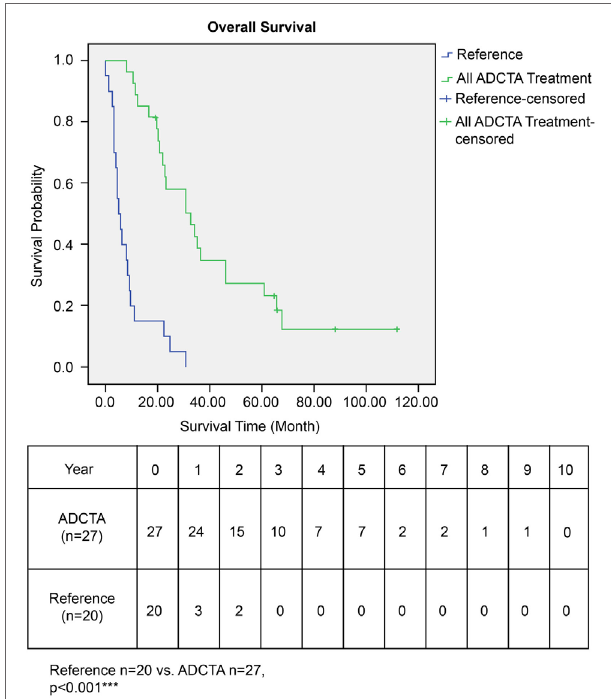
( Figure 5A , Kaplan–Meier estimates of OS, P < 0.001). As